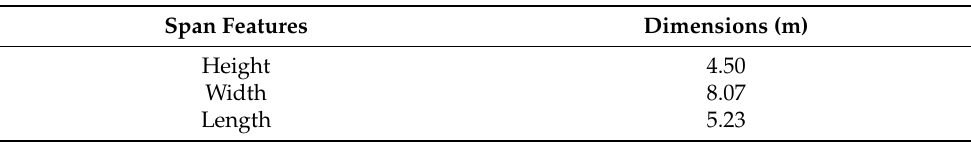
Table 2. “Bridge B” geometry and dimensions: height from Morra Creek bed (m), span width (m), and length